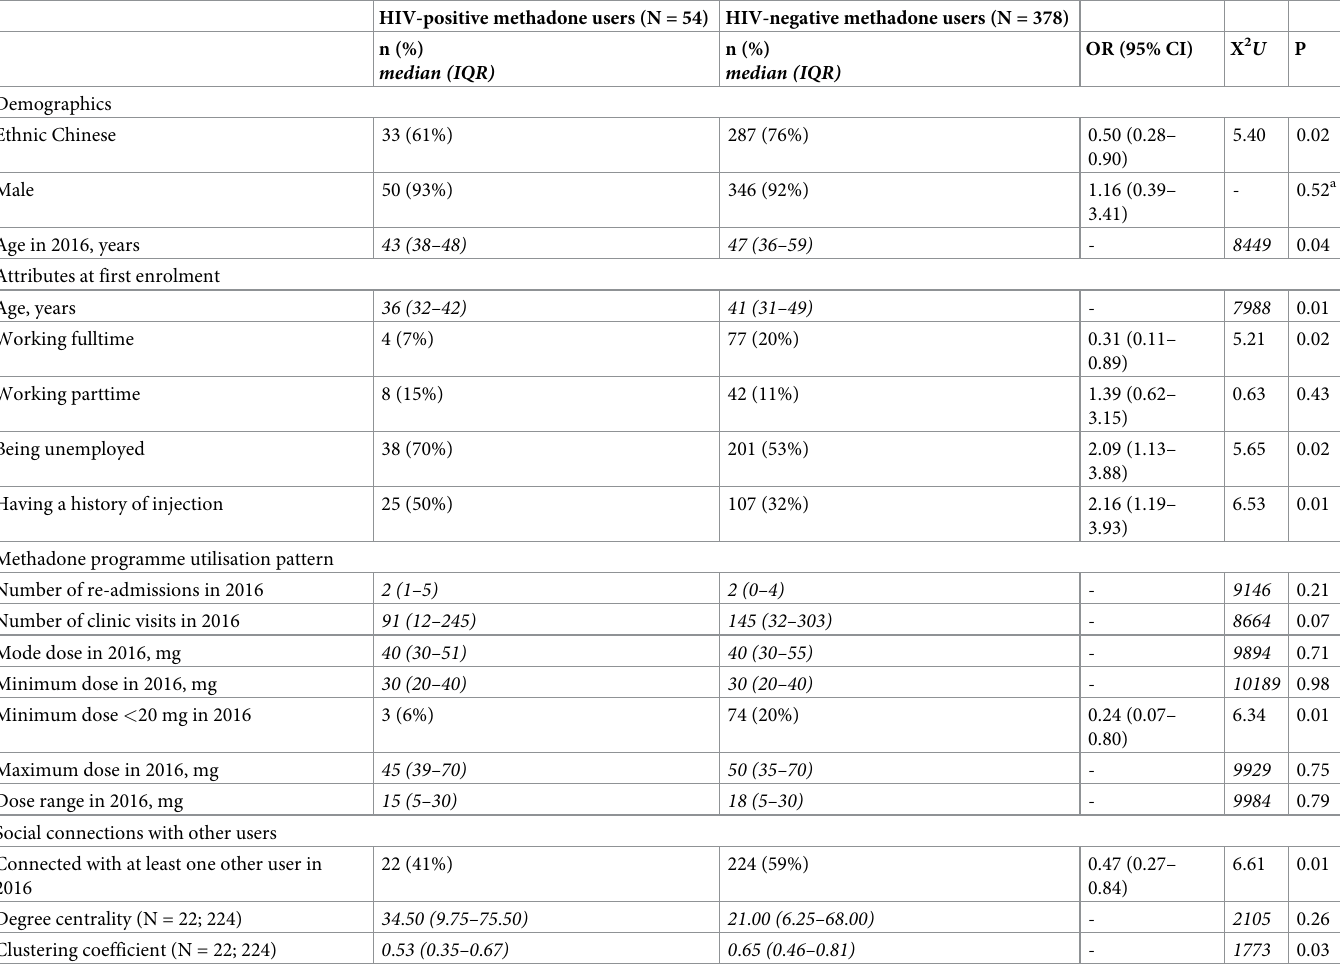
Table 1. Characteristics of case-controlled HIV-positive and negative users who attended the methadone programme in 2016 (N =